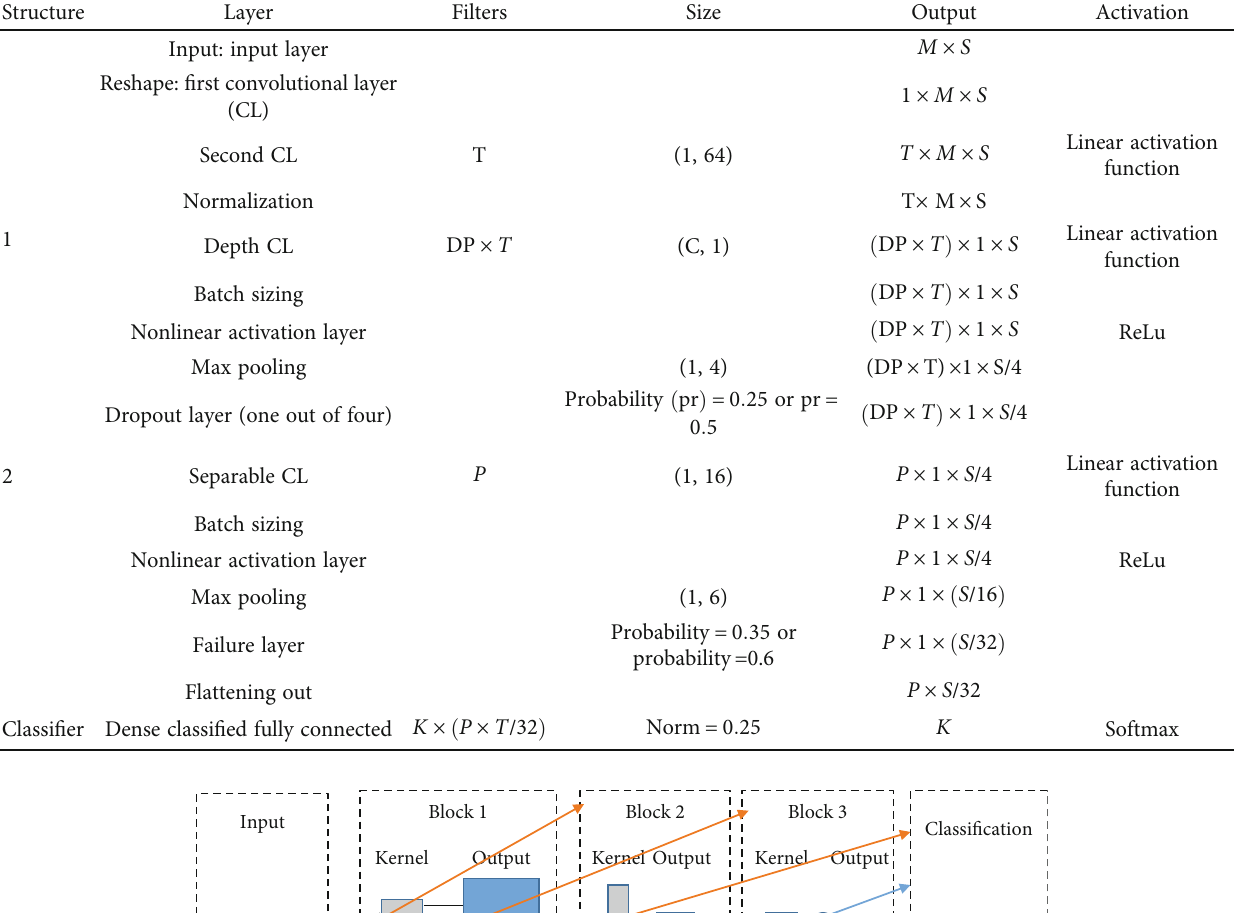
Table 2: Parameter of EEG-DenseNet: T = temporal fi lter, DP = depth, P = point fi lter. K is the count of motor imagery units. Structure